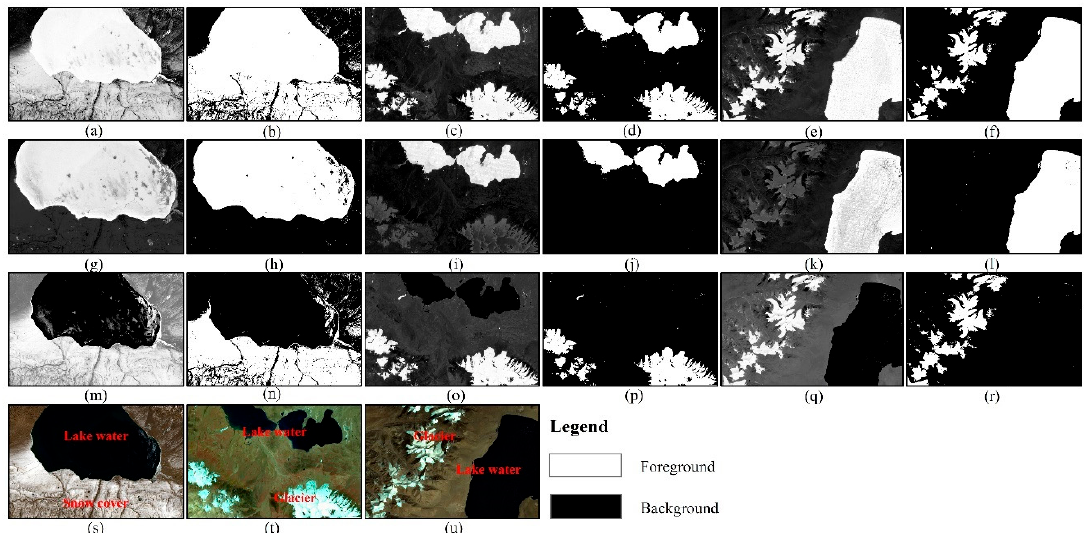
Figure 6. The index images and classified images. ( a , c , e ) are the NDSI / MNDWI image in region I, II